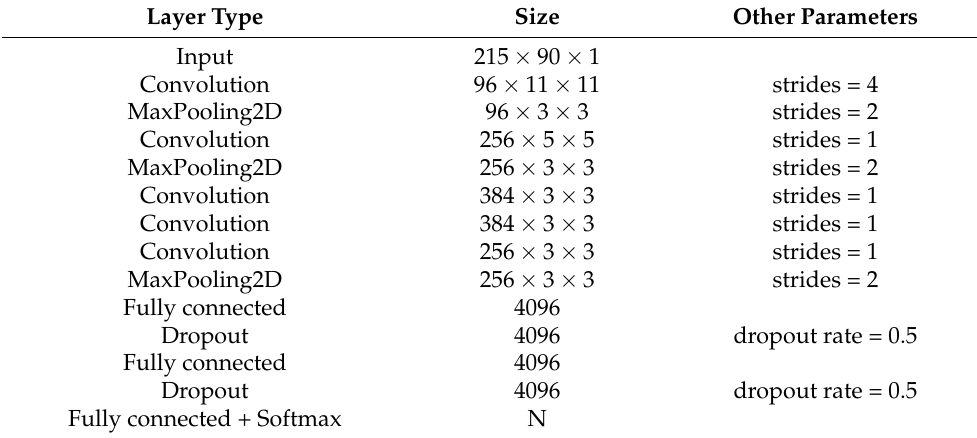
Table 1. Proposed CNN